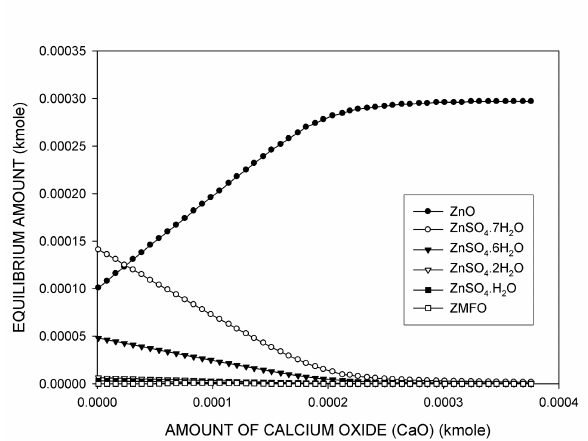
Figure 10(a). Effect of the amount of sulphur on the amounts of the zinc-containing species in the system at 298 K for the Zn-Fe-Mn-O-C-H-S system.